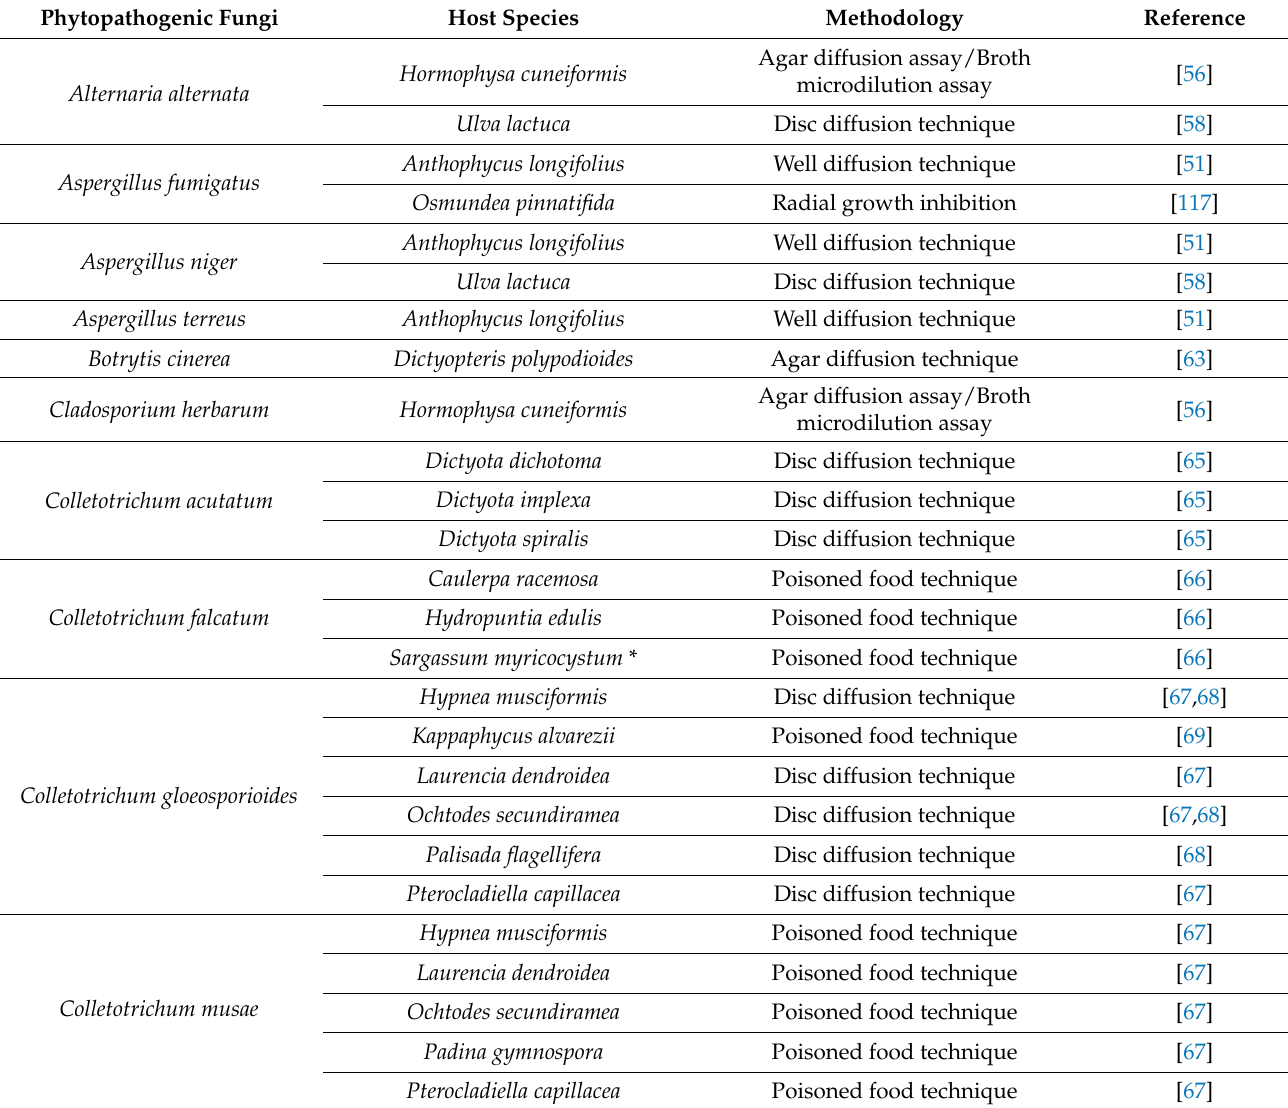
Table 2. Compilation of the best antifungal activities of macroalgae extracts against phytopathogenic fungi obtained using in vitro methodologies (summary of the information available in Scopus up until 25 February 2021). Detailed information regarding the results obtained for each study can be consulted in Supplementary Tables S1–S10. * Algae species not found in the Algaebase